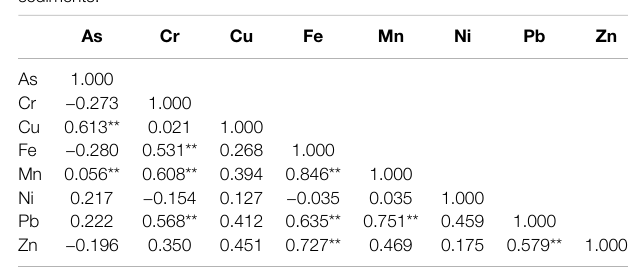
TABLE 4 | Spearman correlation matrix between metal(loid) concentrations of the sediments.